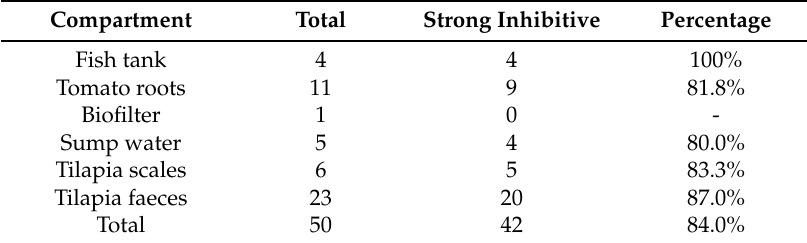
Table 2. Number of selected King’s B medium isolates with strongest inhibition effect from the model aquaponic system, number of effective isolates against the fish pathogen Saprolegnia parasitica (>55% mycelial growth inhibition), and percentage of positive